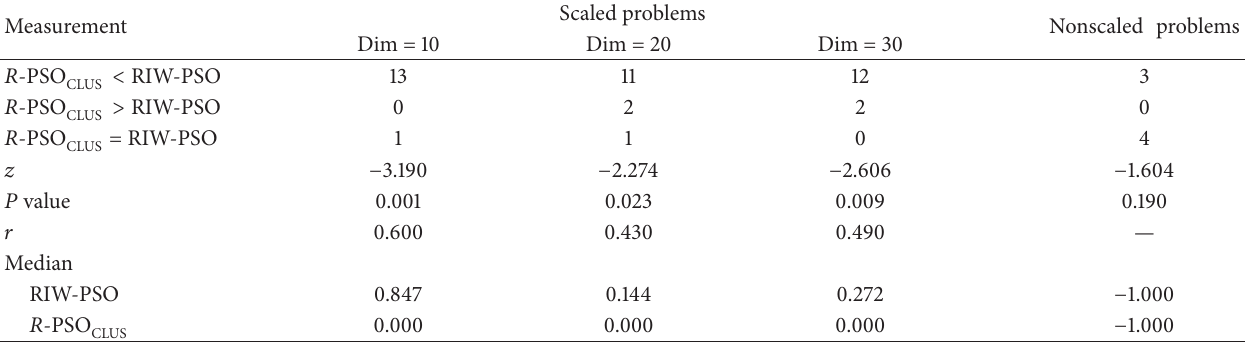
for the test problems. CLUS